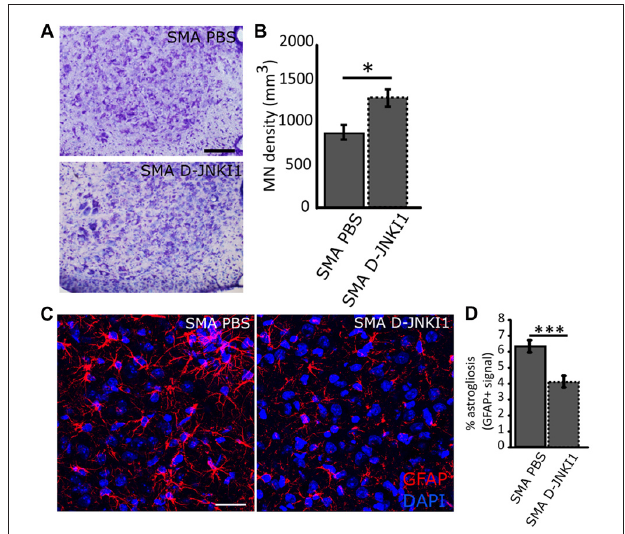
FIGURE 5 | Analysis of MN survival and astrogliosis in the ventral horns of SMA spinal cord at P12, after D-JNKI1 treatment. (A) Nissl-stained MNs in the ventral horns showing differences between PBS-treated and D-JNKI1-treated SMA mice. (B) Quantification of MN density between PBS-treated and D-JNKI1-treated SMA pups. (C) Representative images showing a reduction in glial fibrillary acidic protein (GFAP) signal (astrogliosis) between PBS and D-JNKI1 SMA groups. (D) Quantification of the percentage of astrogliosis, in terms of GFAP+ signal, in the ventral horns of SMA-PBS and SMA-D-JNKI1 animals. Scale bars: 50 µ m (A) ; 40 µ m (C) . ∗ P < 0.05; ∗∗∗ P <